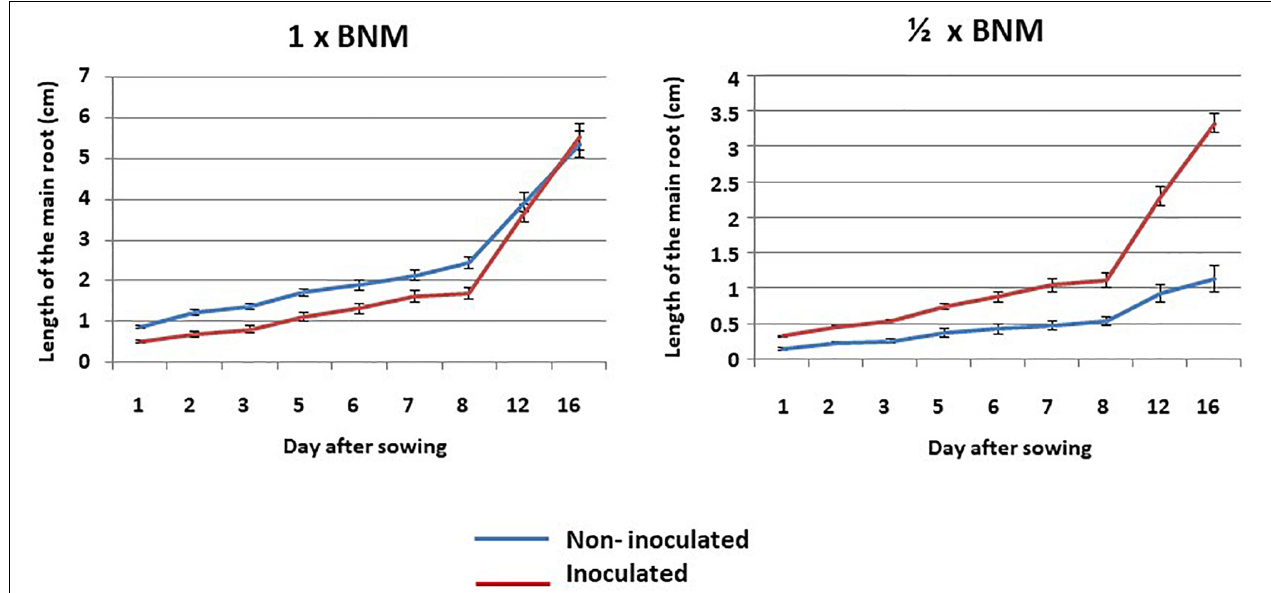
FIGURE 1 | Kinetics of root growth in non-inoculated and inoculated plants of Medicago sativa grown in vitro in square plates. Values represent mean ± SE, n =